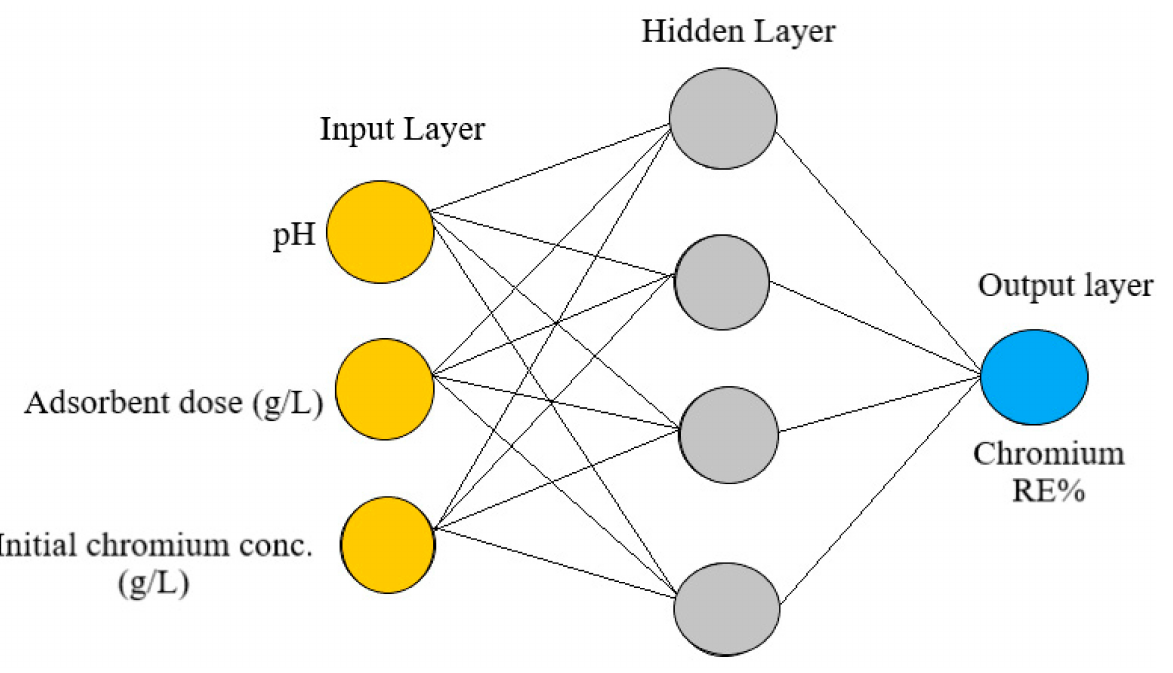
Figure 1. Artificial neural network architecture.